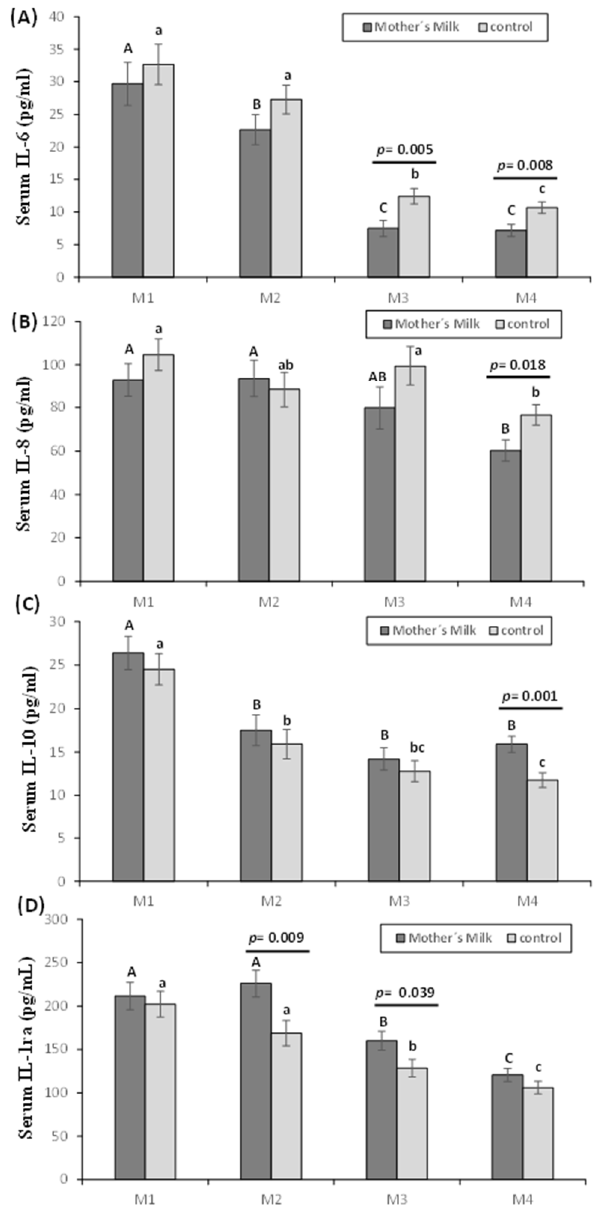
Figure 2. E ff ect of oropharyngeal mother’s milk administration on the levels of IL-6 ( A ), IL-8 ( B ), IL-10 ( C ), and IL1-ra ( D ) in serum. Results are expressed as mean ± standard error of the mean. A line between bars means statistically significant di ff erences between groups ( p < 0.05). Di ff erent letters in every group indicate significant di ff erences due to the time (mother’s milk (A, B, C), control (a, b, c) ( p < 0.05)). M1: Birth (basal value), M2: 3rd day of postnatal life; M3: 15th day of postnatal life, M4: 30th day of postnatal life.